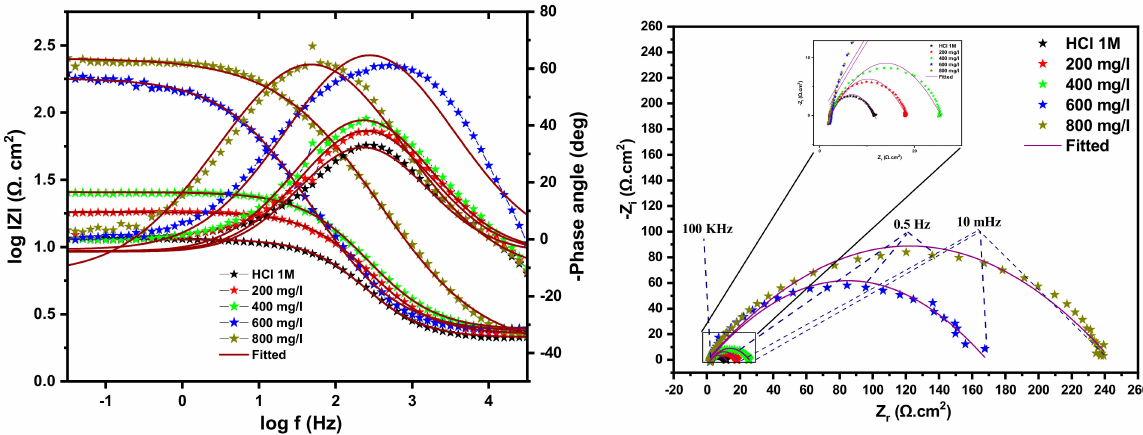
Figure 5. Nyquist and Bode plots in the presence and absence of the CHA extract at temperature 298 K.